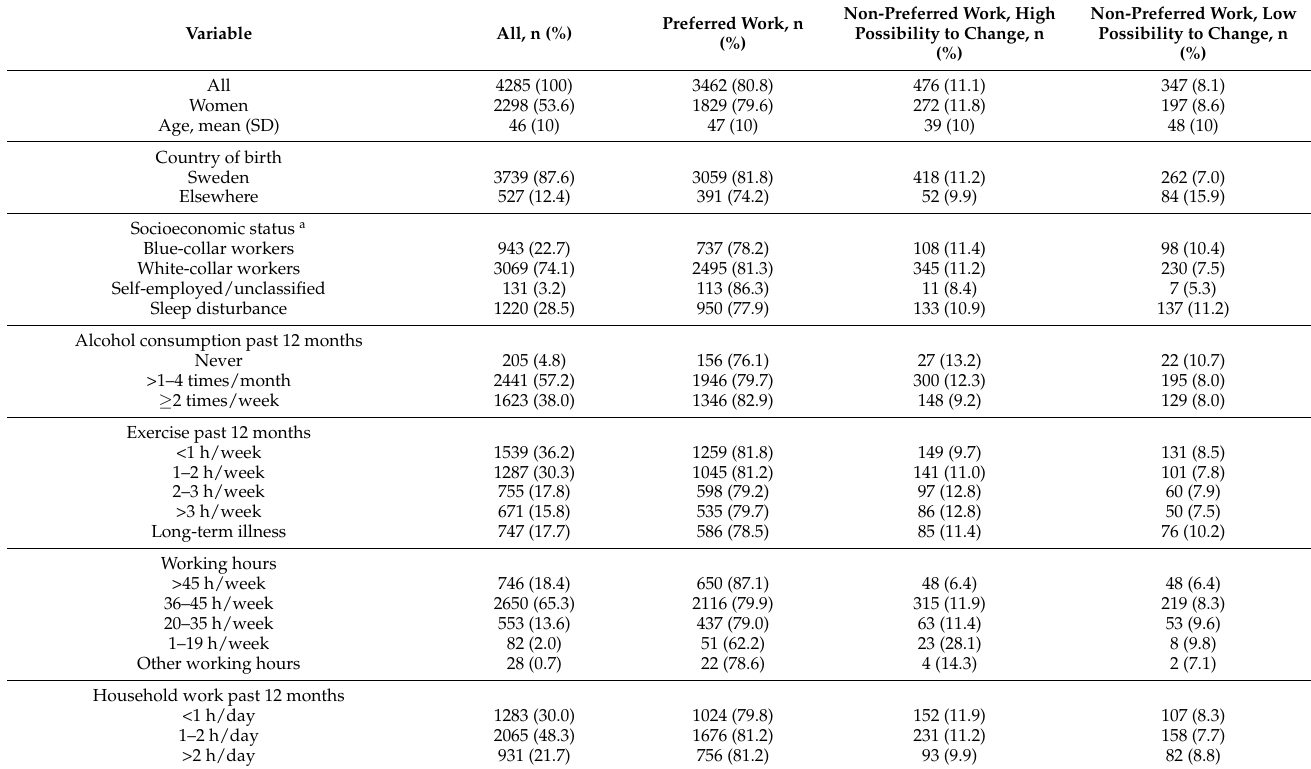
Table 2. Baseline characteristics of study sample categorized by exposure (n =